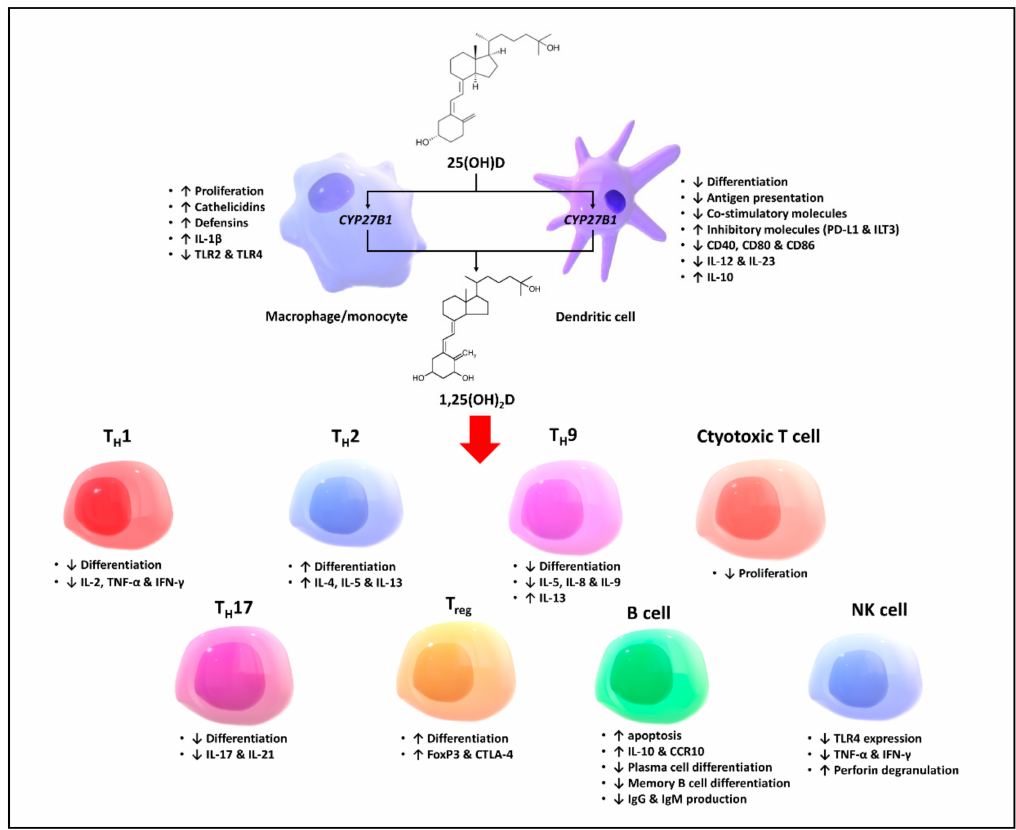
Figure 3. Effects of vitamin D on different cell types of the innate and adaptive immune systems. ↑ : Increased; ↓ : Decreased; 1,25(OH) 2 D: 1,25-dihydroxyvitamin D; 25(OH)D: 25-hydroxyvitamin D; CCR10: C-C chemokine receptor type 10; CTLA-4: cytotoxic T-lymphocyte-associated protein 4; CYP27B1: cytochrome P450 family 27 subfamily B member 1; FoxP3: